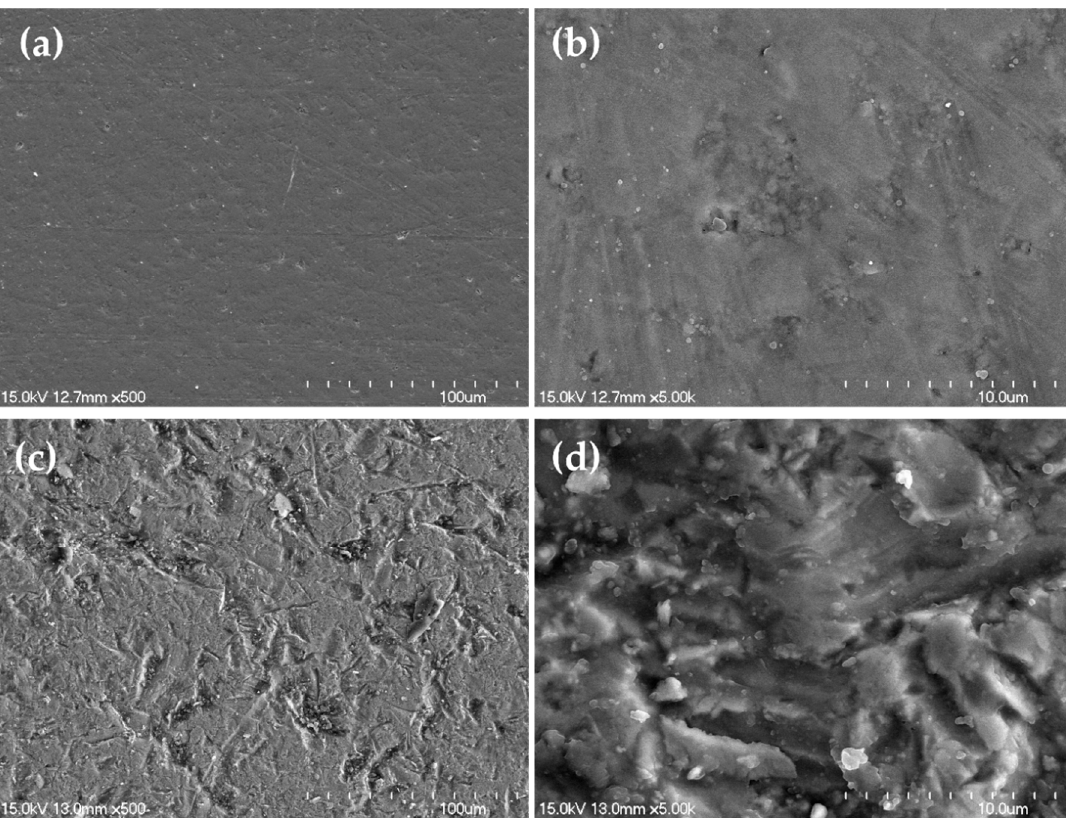
Figure 2. Field emission scanning electron microscope (FE-SEM) images of surface of yttrium-stabilized tetragonal zirconia polycrystal (Y-TZP) before; ( (a) ×500; (b) ×5000) and after alumina sandblasting; ( (c) ×500; (d) ×5000).